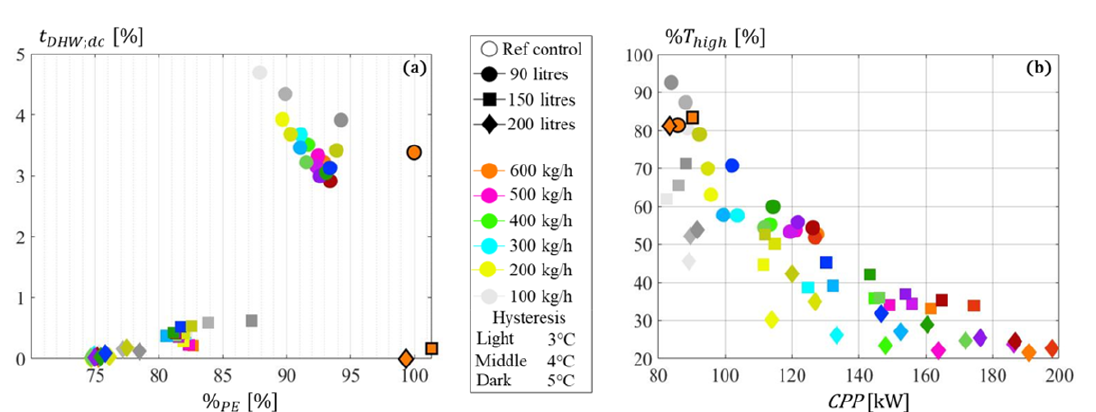
Figure 8. Two-sensor control: Pareto analysis of ( a ) t DHW ; dc and % PE , and ( b ) % T high and CPP for different volumes (different shapes), charging flow rates (different colours), and hysteresis (darkness of certain colour). The REF-control is outlined in black. The 2SC consistently consumes less PE than REF-control, and the t DHW ; dc and % PE are similar for different ˙ m ch and hysteresis values in the case of large storage volumes. By lowering ˙ m ch , the CPP for the 2SC can be reduced to the level of